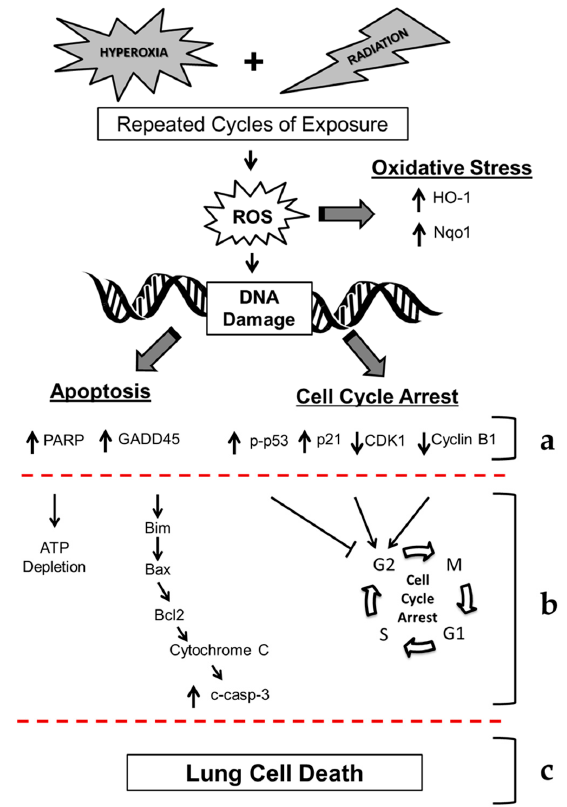
Figure 12. Mechanism of cell death in murine lung epithelial cells after repeated cycles of hyperoxia, radiation, and double-hit combination challenge. Hyperoxia and radiation exposure generates reactive oxygen species (ROS) that lead to increases in DNA damage. Oxidative stress induces the expression of cytoprotective enzymes (HO-1 and Nqo1). We observed significant increases in molecular markers of DNA damage ( γ -H2AX, GADD45 α and cleaved-PARP), along with a key upstream executioners of apoptosis (cleaved caspase-3). ( a ) Additionally, we observed increased Annexin-V, a marker of